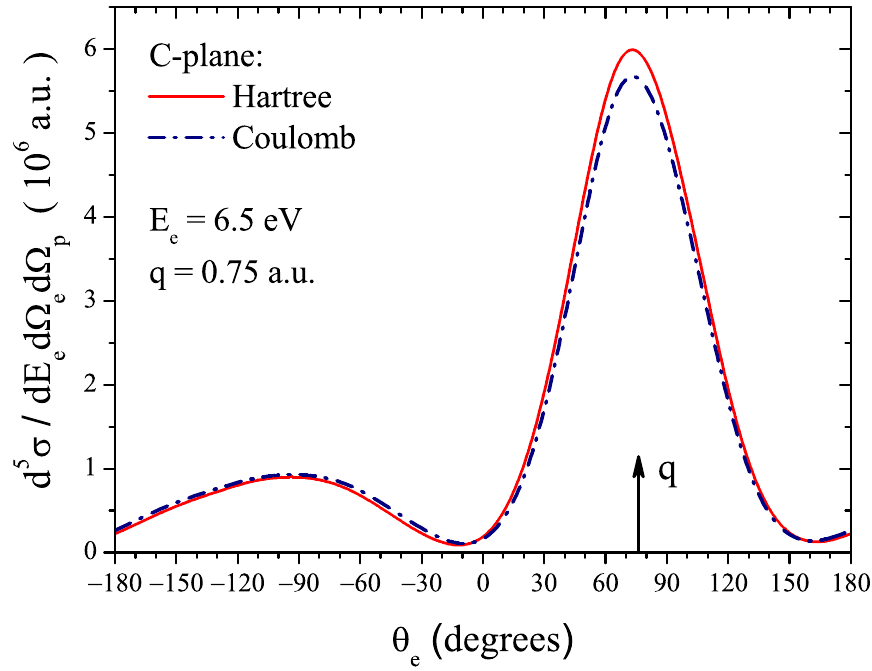
Figure 2. FDCS for single ionization of helium by 1-MeV protons in the collision plane. The electron emission energy is E e = 6.5 eV, and the total momentum transfer q = 0.75 a.u. Solid curve shows the results obtained with the Hartree potentials for the ( e − ,He + ) and ( p + ,He + ) systems. Dash-dotted line corresponds to the case of pure Coulomb interactions. The arrow indicates the direction of the momentum